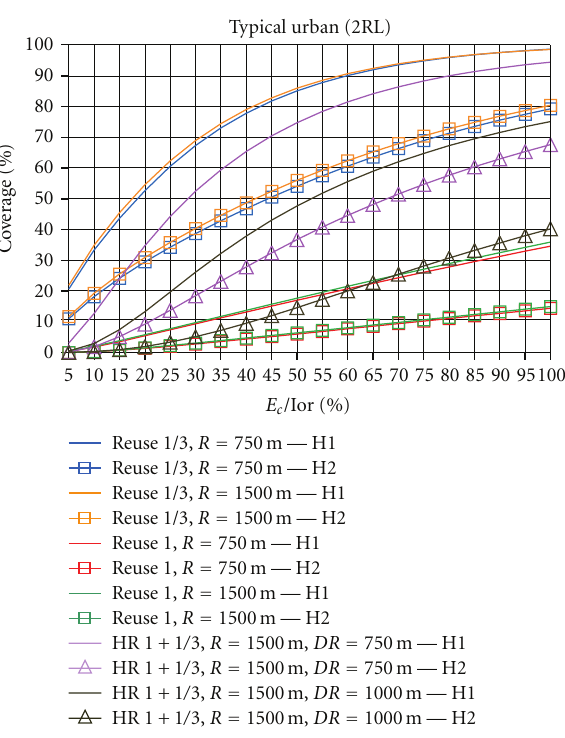
Figure 11: Coverage versus E c /Ior SC-PTM (1RL) scenario.